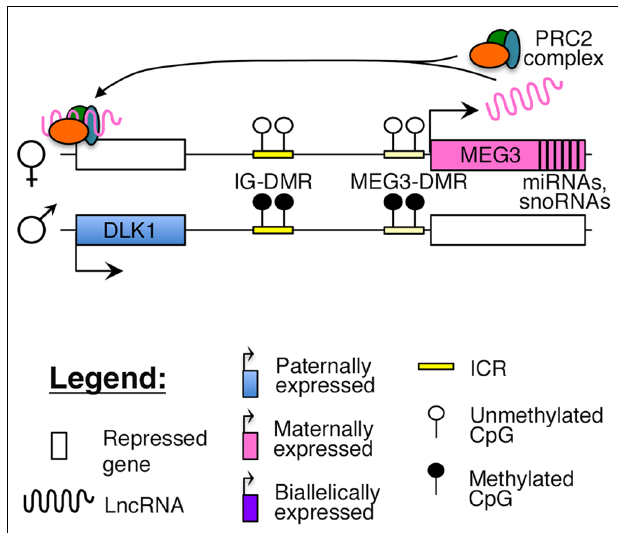
FIGURE 1 | Proposed model of imprinting at the DLK1–MEG3 locus: the DLK1–MEG3 imprinted region contains a primary ICR (IG-DMR) and secondary ( MEG3– DMR) ICR that overlaps with the promoter of the MEG3 . Both ICRs are paternally methylated. In mouse ES cells, the Meg3 lncRNA is believed to direct PRC2 mediated silencing of Dlk1 (Zhao etal., 2010).